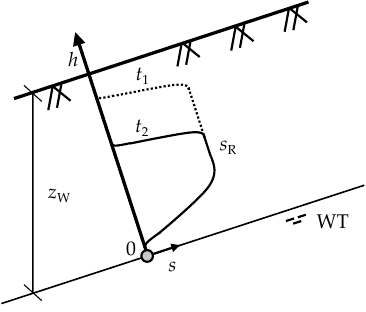
Figure 3. Evolution with time t of the matric suction caused by the advance of a wetting front ( t 2 > t 1 ).